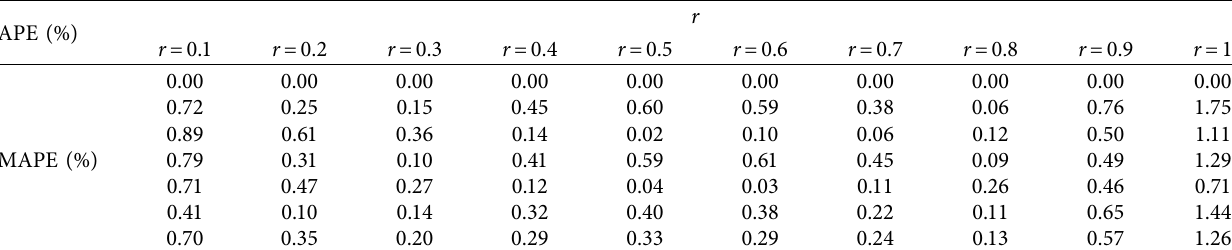
Table 3: Error comparison (an example of